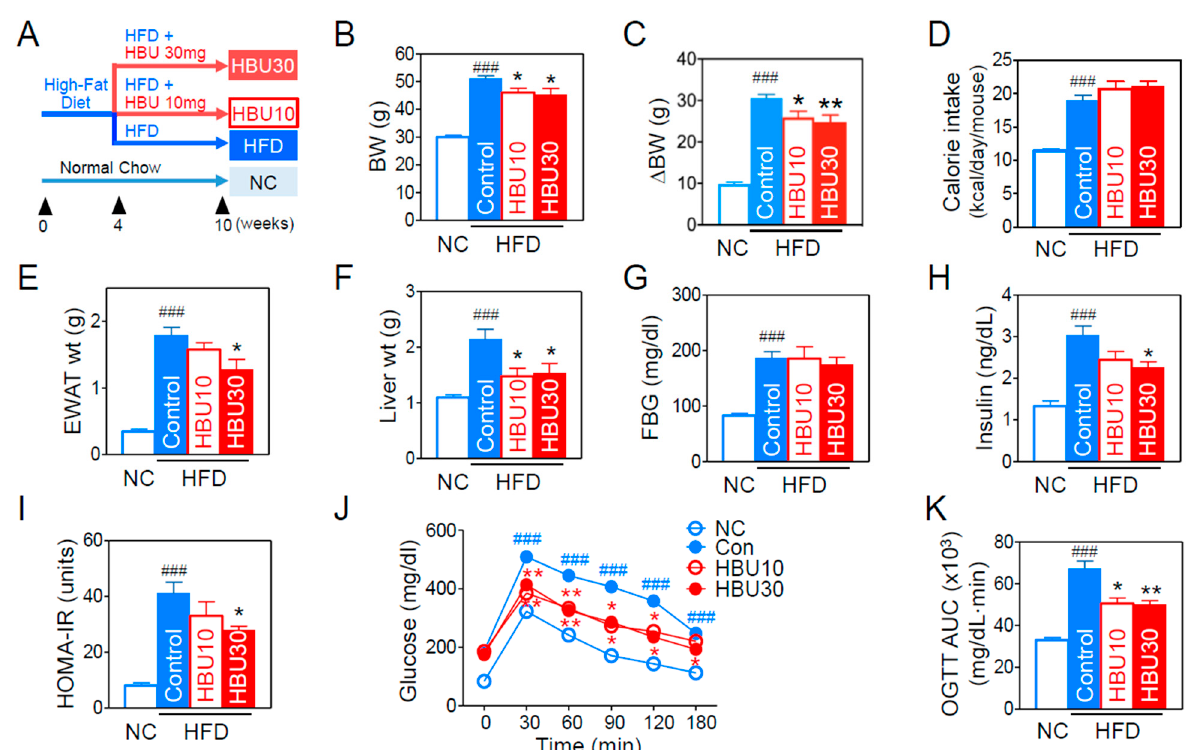
Figure 3. Effects of HBU651 on metabolic phenotypes in HFD-induced obese mice. ( A ) Experimental scheme in vivo, ( B ) Body weight (BW, g) at the end of the experiment, ( C ) Changes of BW, ( D ) Oral calories intake, ( E ) Epididymal white adipose tissue (EWAT) weight, ( F ) Liver weight, ( G ) Fasting blood glucose (FBG), ( H ) Fasting insulin, ( I ) Homeostatic model assessment of insulin resistance (HOMA-IR), ( J ) Time-course changes of blood glucose in the oral glucose tolerance test (OGTT), ( K ) Area under the curve (AUC) of OGTT. Data are expressed as means ±SEM ( n = 5). ### p < 0.001 vs. NC, and * p < 0.05, ** p < 0.01 vs. HFD-control. NC, normal chow; Control, HFD-control; HBU10, HFD plus HBU651 10 mg/kg; HBU30, HFD plus HBU651 30 mg/kg.